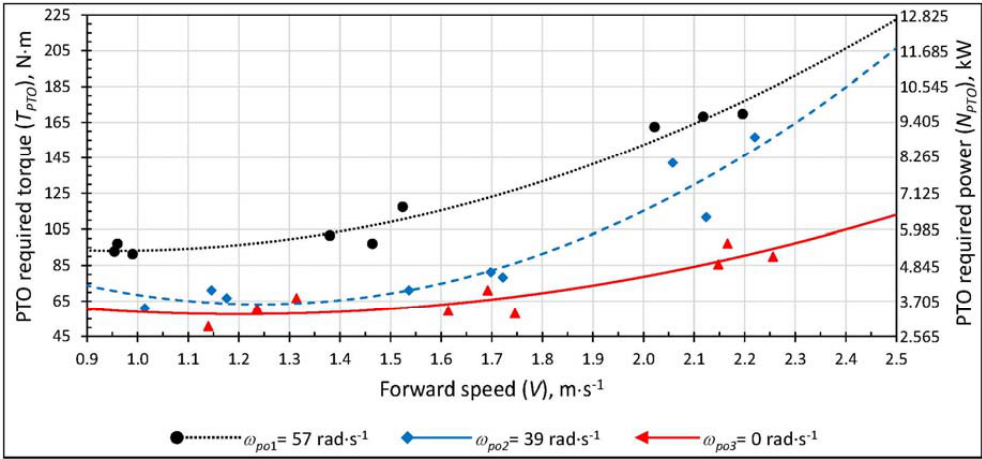
Figure 7. PTO required torque T PTO and power N PTO vs. aggregate tractor – beet top harvester forward speed V for different screw conveyor drive shaft angular speeds.